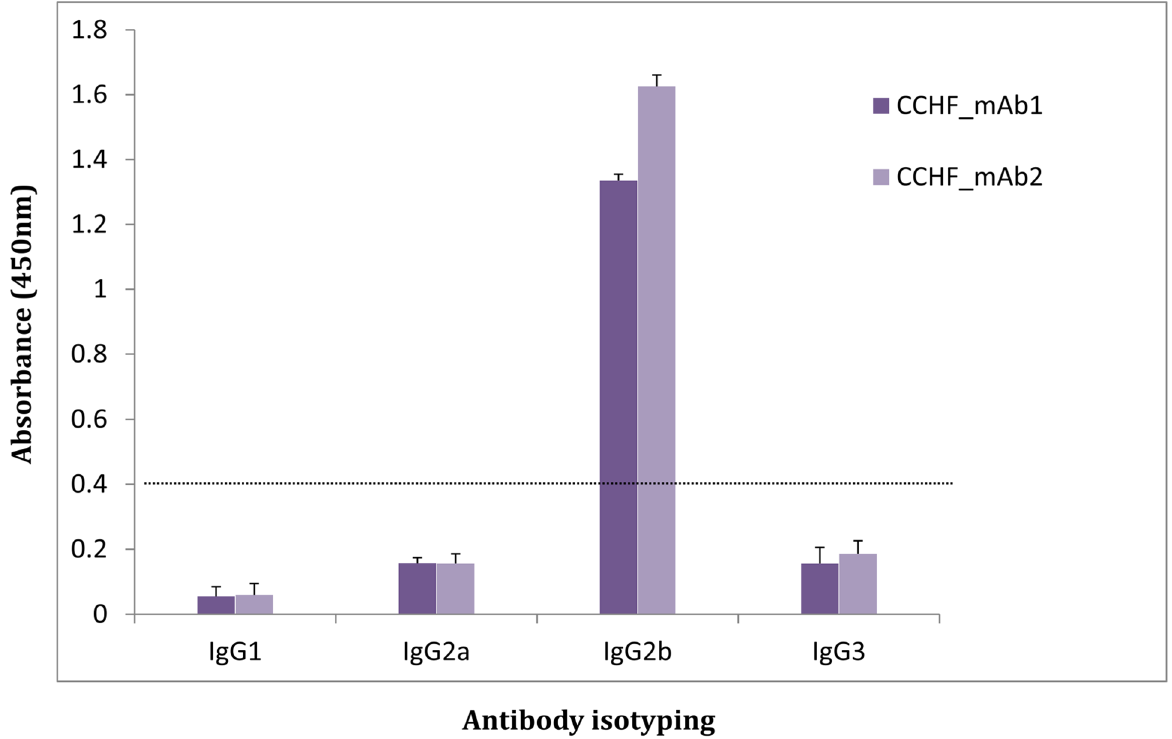
Figure 3. Isotyping of monoclonal antibodies (CCHF_mAb1 and CCHF_mAb2), analysed for isotypes IgG1, IgG2a, IgG2b, IgG3, using indirect ELISA in duplicates with depicted cut-off value of 0.37.